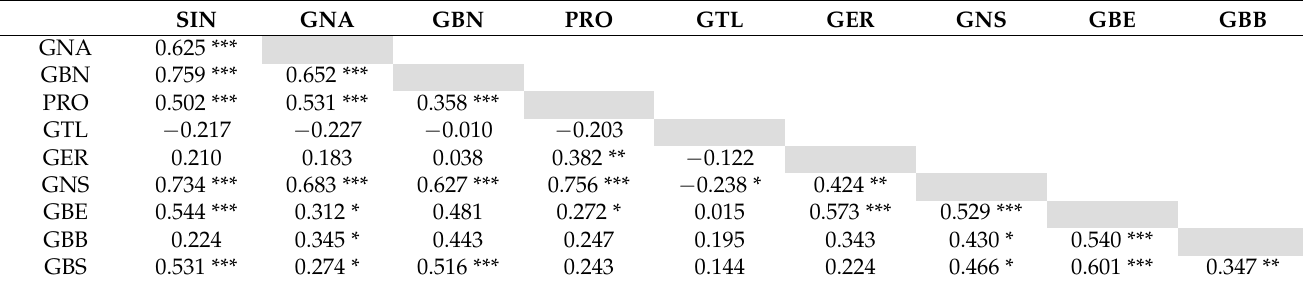
Table 3. Pearson’s correlation analysis between glucosinolate